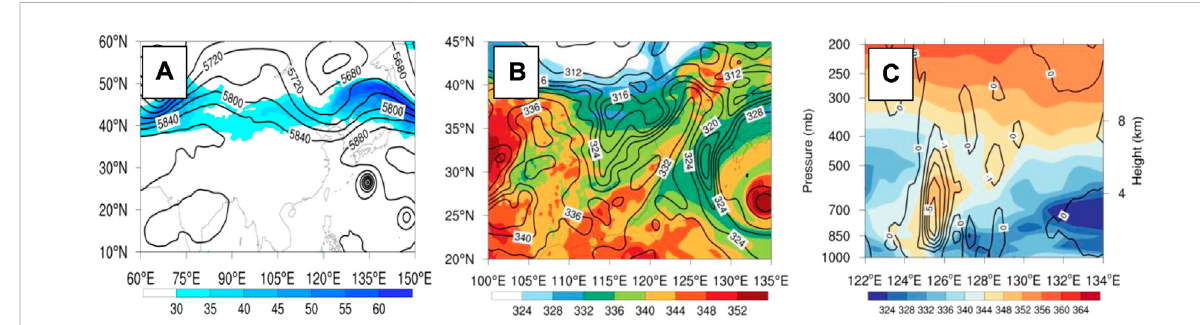
FIGURE 5 (A) 500-hPa height fi eld (contours) with 200-hPa high-altitude rapids ( > 30 m/s, fi lled area), (B) 500-hPa pseudo-equivalent potential temperature ( fi lled area, in K) and 500-hPa 336-K contours (solid black line), and (C) vertical distribution of the pseudo-equivalent potential temperature at 1200 UTC on 20 August